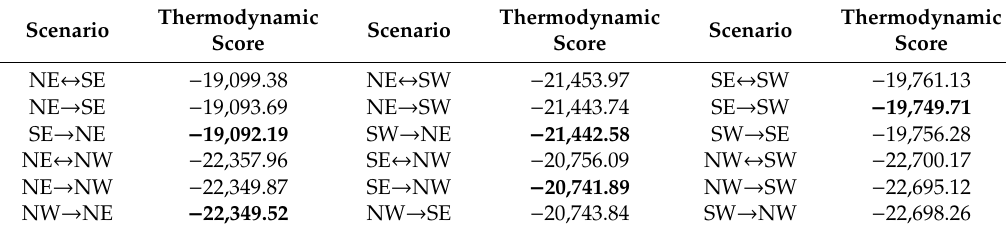
Figure 6. Gene flow estimates for L. chinense . Arrow width depicts the extent of gene flow between populations. ( a ) “Current” species distribution model of L. chinense ; warmer colors represent areas of higher habitat suitability. ( b ) Digital elevation model (DEM) and distribution of mainly mountains in subtropical China. ( c ) We estimated gene flow between each pair of the four populations with a coalescent-based framework implemented in MIGRATE 3.6.11, and the numbers in rectangles represent e ff ective population size. ( d ) The results of MIGRATE overlaid onto the dispersal network. Table 7. Marginal likelihood values of all migration models.